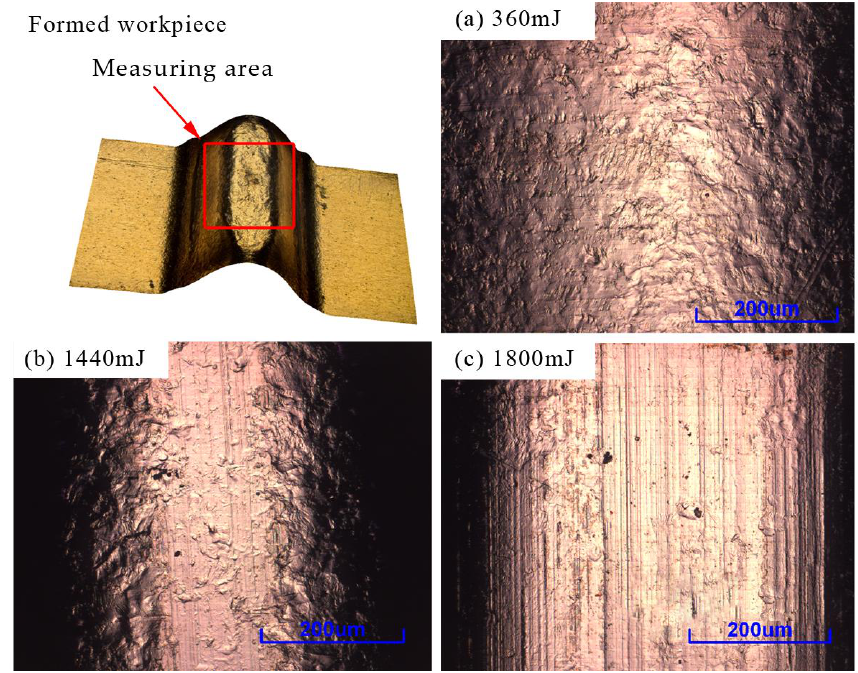
Figure 8. Three different forms of forming process at different laser energy: ( a ) 360 mJ, ( b ) 1440 mJ and ( c ) 1800 mJ.